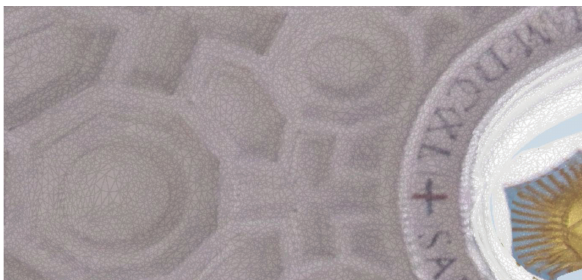
Figure 3. Detail of image based triangulated mesh